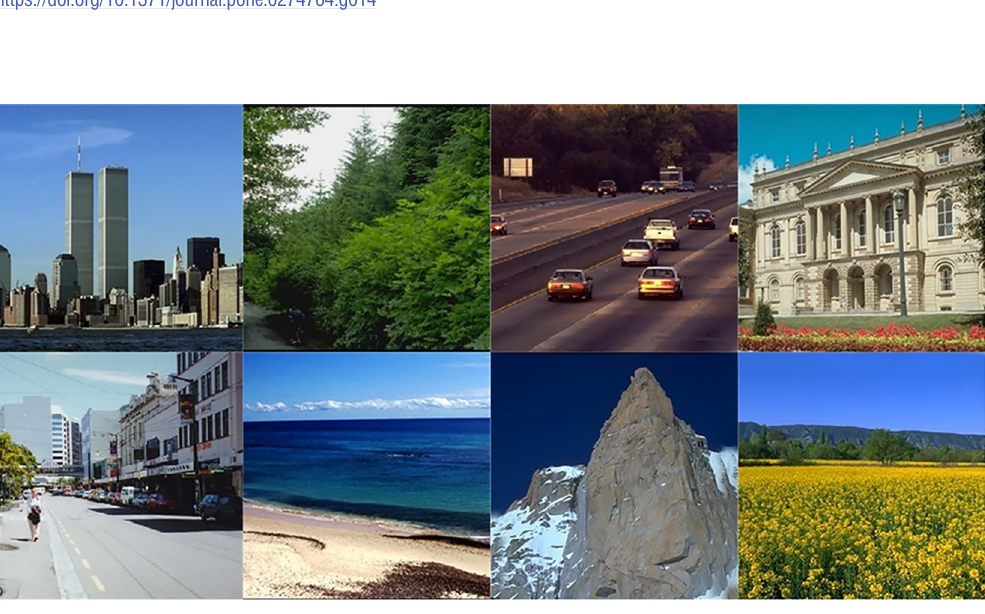
Fig 15. Sample images of the OT Scene dataset